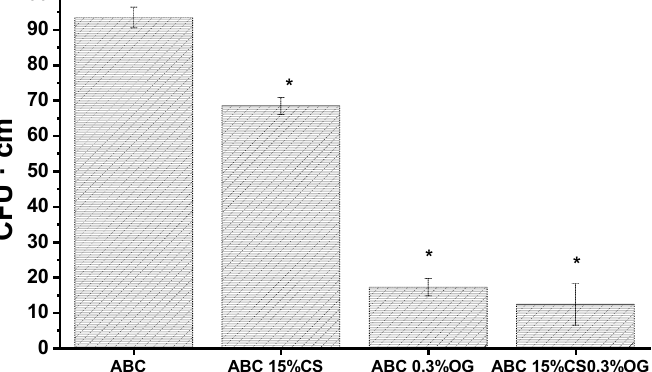
Figure 11. Number of colonies forming units recovered from ABCs surfaces after incubation of E. coli cultures for 24 h. Results are the mean ± SD. Statistical analysis ( n = 12) for each group was performed comparing experimental ABCs samples respect to ABC group at a significance level of p < 0.01.